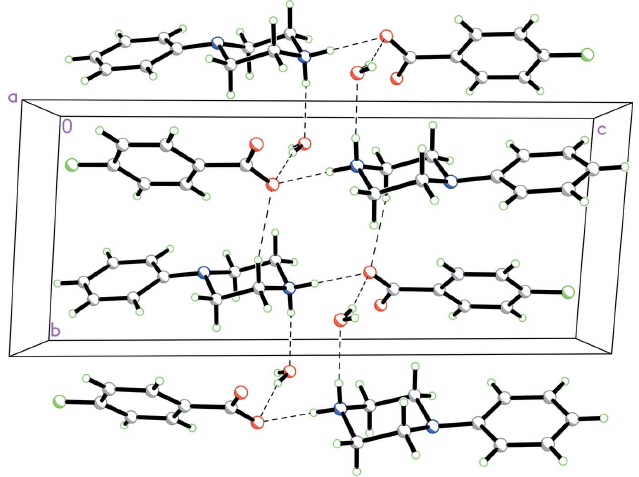
arrangement for 3 shown in Fig. 13, both R 4 N—H (cid:2) (cid:2) (cid:2) O and O—H (cid:2) (cid:2) (cid:2) O hydrogen bonds involving the cation, anion and water molecule as well as R 2 showing O—H (cid:2) (cid:2) (cid:2) O hydrogen bonds just associated with the cation and anion. These link the cations, anions and water molecules into ribbons propagating in the [101] direction. In